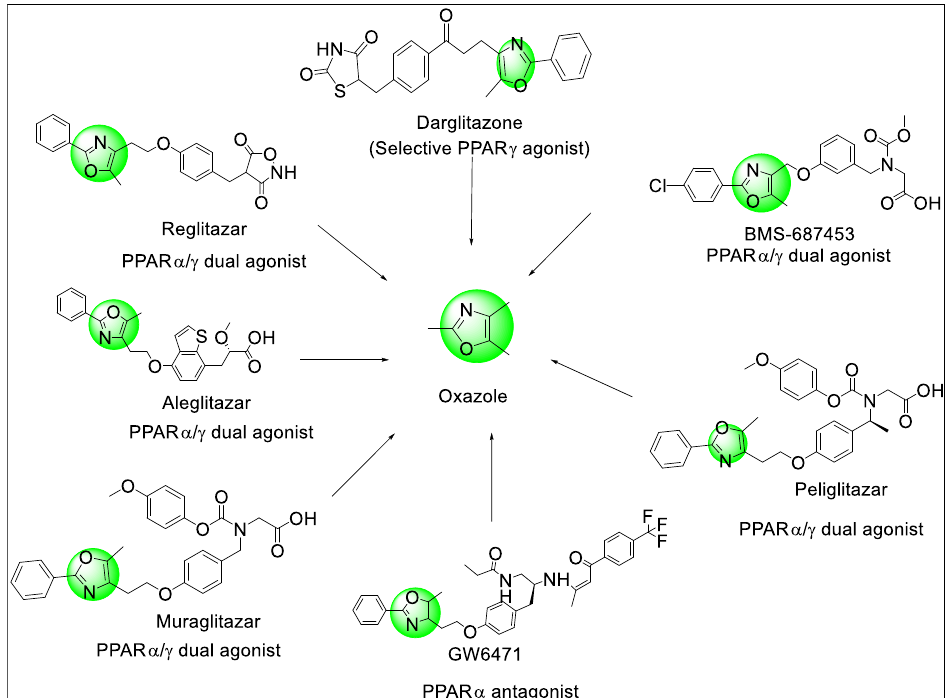
Figure 15. Oxazole scaffold containing PPAR ligands present in the market.